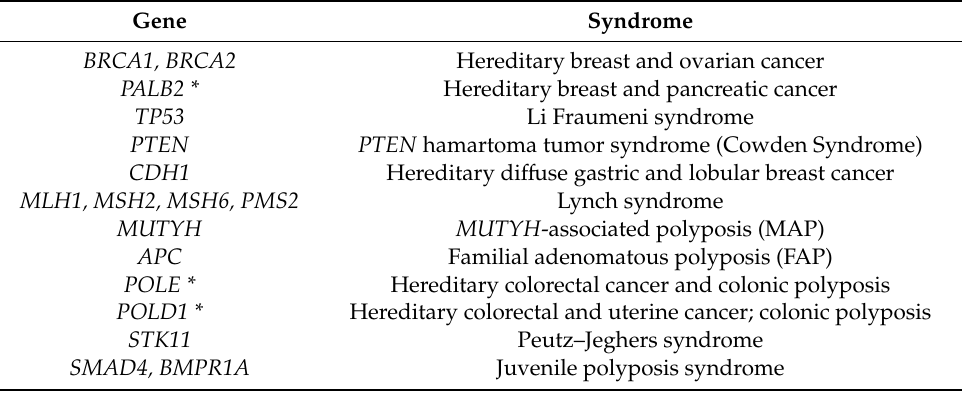
Table 2. Hereditary Cancer Program 17-gene